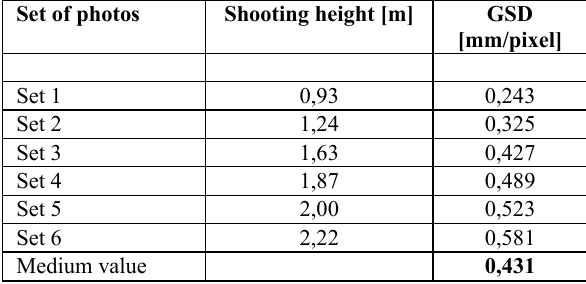
Table 1 . Calculation of ground sample distance.